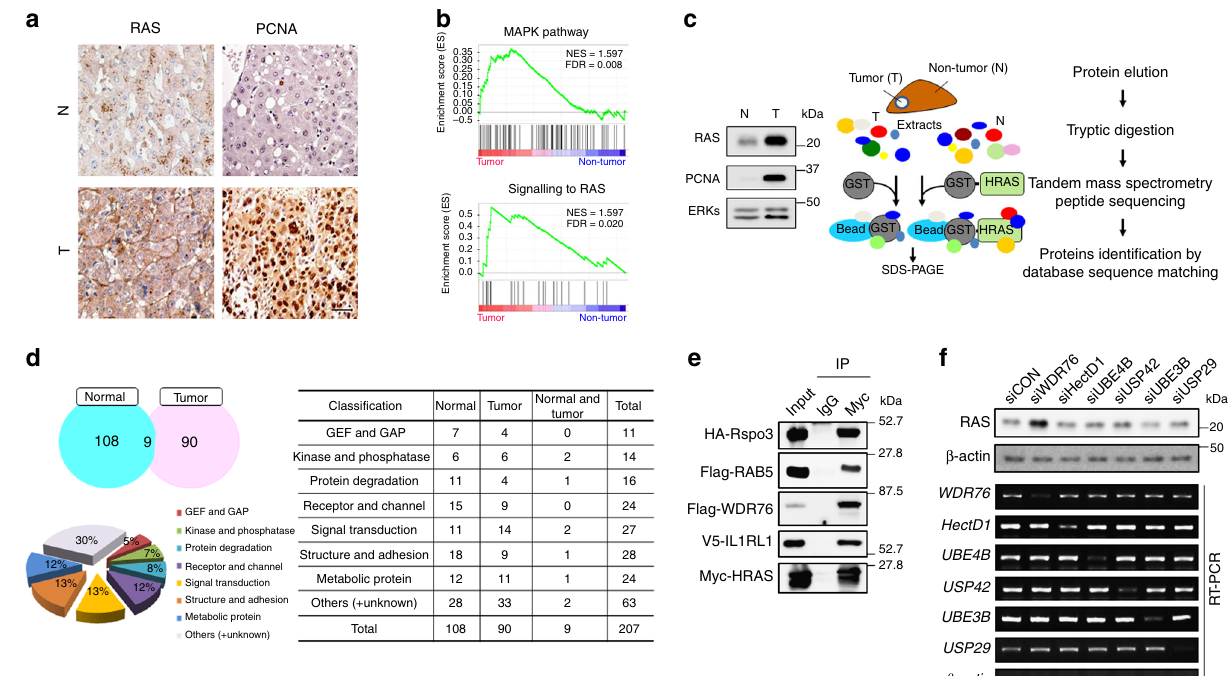
Fig. 1 Identi fi cation of HRAS binding proteins. a Immunohistochemistry of RAS and PCNA in normal (N) and Tumor (T) tissues from patients with HCC. Scale bar, 100 µ m. b GSEA pro fi les of “ MAPK pathway ” and “ signaling to RAS ” signatures between HCC tumors versus non-tumors. NES, normalized enrichment score; FDR, false discovery rate adjusted p -value. c Scheme to identify the HRAS interacting proteins. Total tissue lysates from a patient with HCC, identi fi ed RAS increment in tumor (T) compared with paired normal (N) tissues using immunoblot (IB) assay (left panel), were subjected to af fi nity puri fi cation using puri fi ed GST-HRAS or GST. Each puri fi ed protein complex was resolved on an SDS-PAGE gel and the bands were retrieved and analyzed by LC/MS-MS. d Classi fi cation of the identi fi ed HRAS interactomes. HRAS interactors identi fi ed using LC/MS-MS were categorized according to function. The numbers indicate identi fi ed HRAS interacting proteins for each category. e HEK293 cells were transfected with HA-Rspo3, Flag-RAB5, Flag-WDR76, or V5-IL1RL1, together with Myc-HRAS expression vector. Whole cell lysates (WCLs) were immunoprecipitated with anti-Myc antibody, and IB assay was performed with indicated antibodies. f HEK293 cells were transfected with siRNAs for control (CON), WDR76 , HectD1 , UBE4B , USP42, UBE3B , or USP29 . The mRNA levels of each gene were detected by real-time polymerase chain reaction (RT-PCR). The RAS and β -actin were detected by